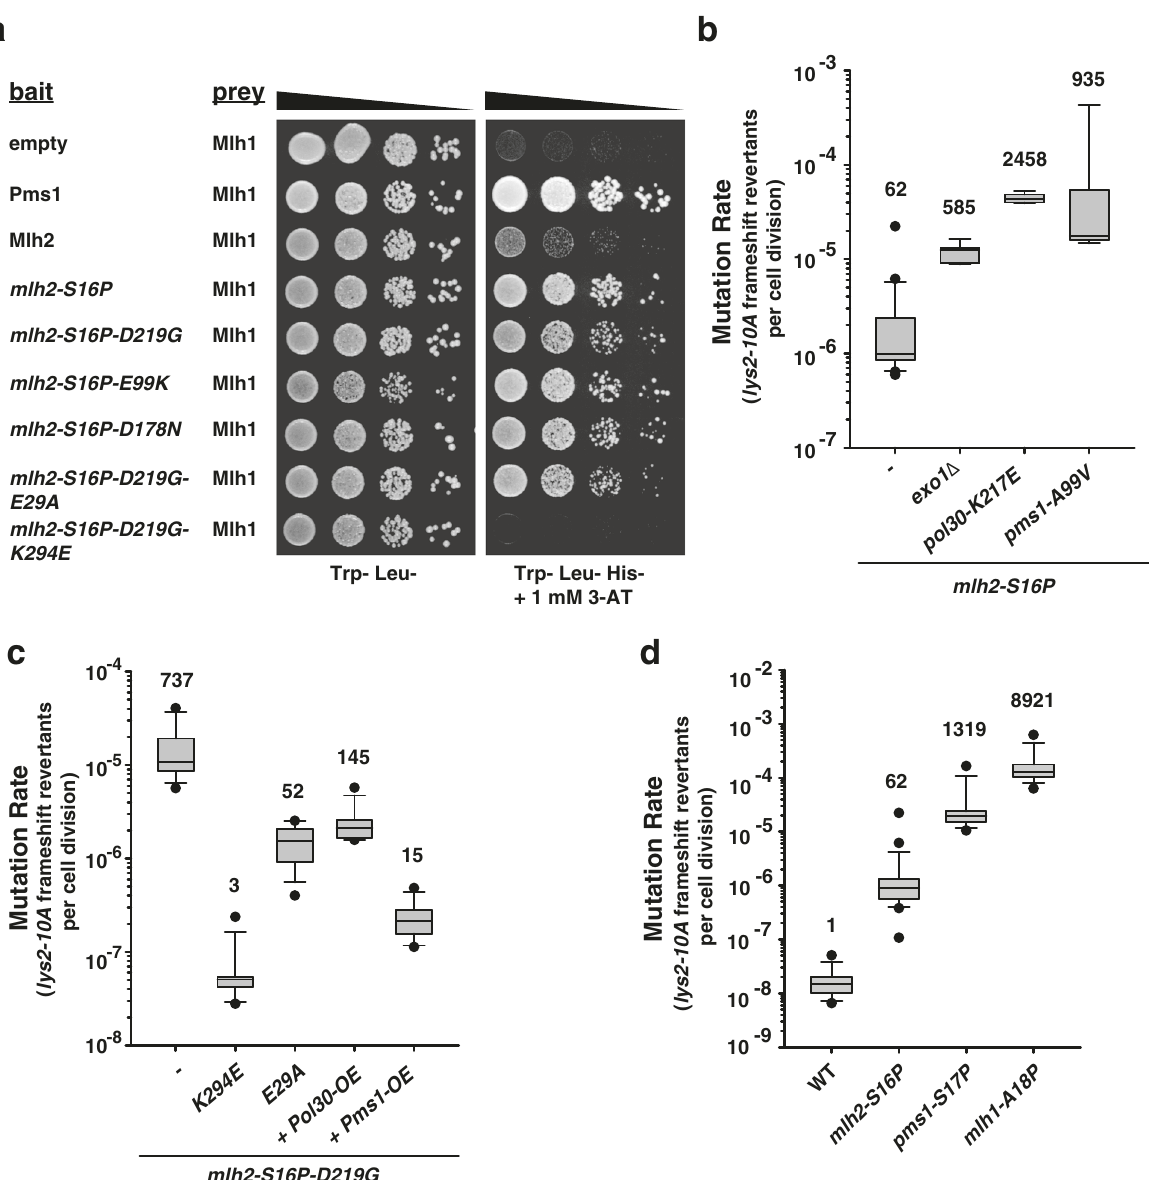
Fig. 4 mlh2-S16P mutation results in an increased interaction with Mlh1 and interferes with Exo1-dependent and Exo1-independent MMR pathways. a The interaction between Mlh1 (prey) and WT- or mutant Mlh2 (baits) proteins was tested by Y2H. Prey and bait plasmids contain TRP1 and LEU2 auxotrophic markers, respectively. Interaction was scored as growth on Trp − Leu − His − + 1 mM 3- AT plates. Cells were spotted in serial dilutions on control (Trp − Leu − ) or reporter plates (Trp − Leu − His − + 1 mM 3-AT). Mlh1 and Pms1 proteins serve as positive control for the Y2H interaction. b – d Box plots with whiskers showing mutation rates in the indicated strains using the lys2-10A frameshift reporter. The numbers on top correspond to the fold increase in mutation rates over the WT. Black dots indicate